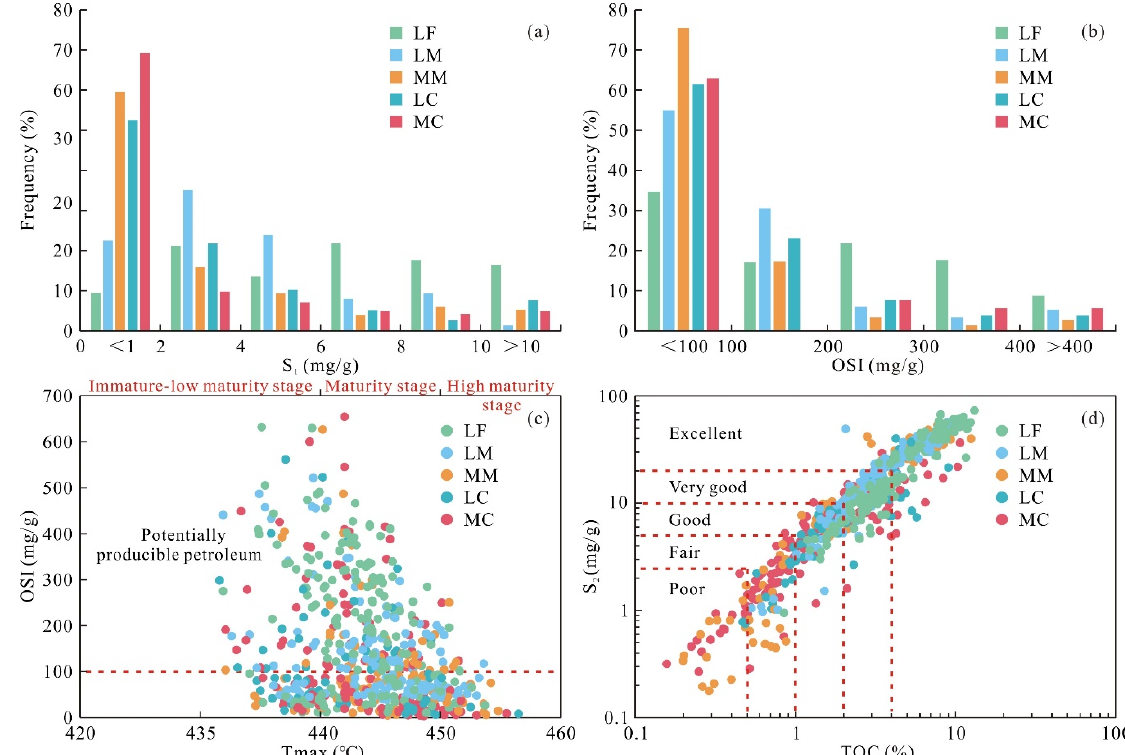
Figure 7. Oil-bearing characteristics of the Ek 2 shales in the Cangdong Sag. ( a ) Frequency distribution histogram of S 1 . ( b ) Frequency distribution histogram of OSI. ( c ) Diagram of OSI versus T max . ( d ) Diagram of S 2 versus TOC. LF: laminated felsic shale; LM: laminated mixed shale; MM: massive mixed shale; LC: laminated carbonate shale; MC: massive carbonate shale.